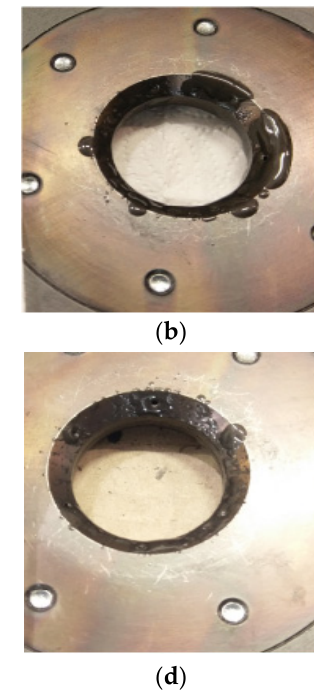
( b ) variant 3; ( c ) variant 2; ( d ) variant 4.